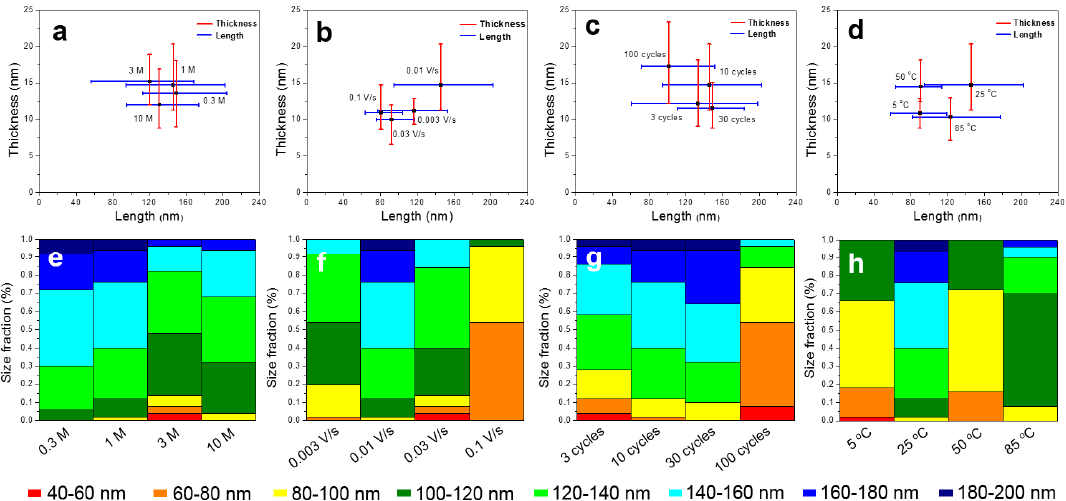
Figure 4. ( a – d ) The size statistics of MgO nanoplates obtained under different experimental parameters; ( e – h ) fractions of MgO nanoplates with different sizes obtained under different experimental parameters; ( a ) and ( e ): solution concentrations; ( b ) and ( f ): sweep rates; ( c ) and ( g ): cycle numbers; ( d ) and ( h ): reaction temperatures.